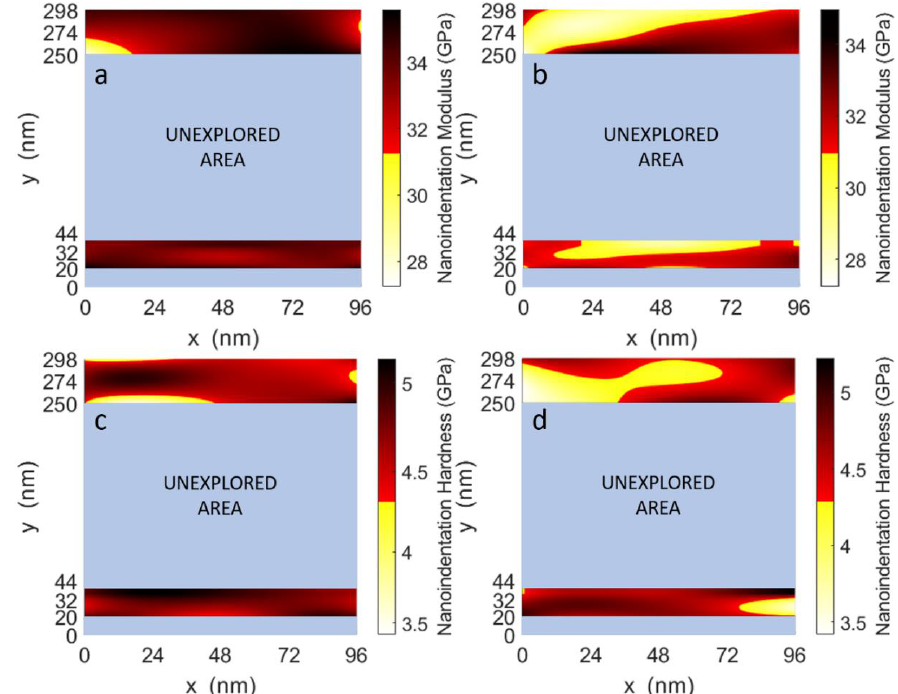
Figure A2. Representative color maps of the micromechanical properties obtained for orifice samples characterized by a diameter of 29 mm. ( a , b ) represent the distribution of the nanoindentation modulus obtained for the old deposition process and the new deposition process respectively. ( c , d ) Represent the distribution of the nanoindentation hardness obtained for the old deposition process and the new deposition process, respectively.